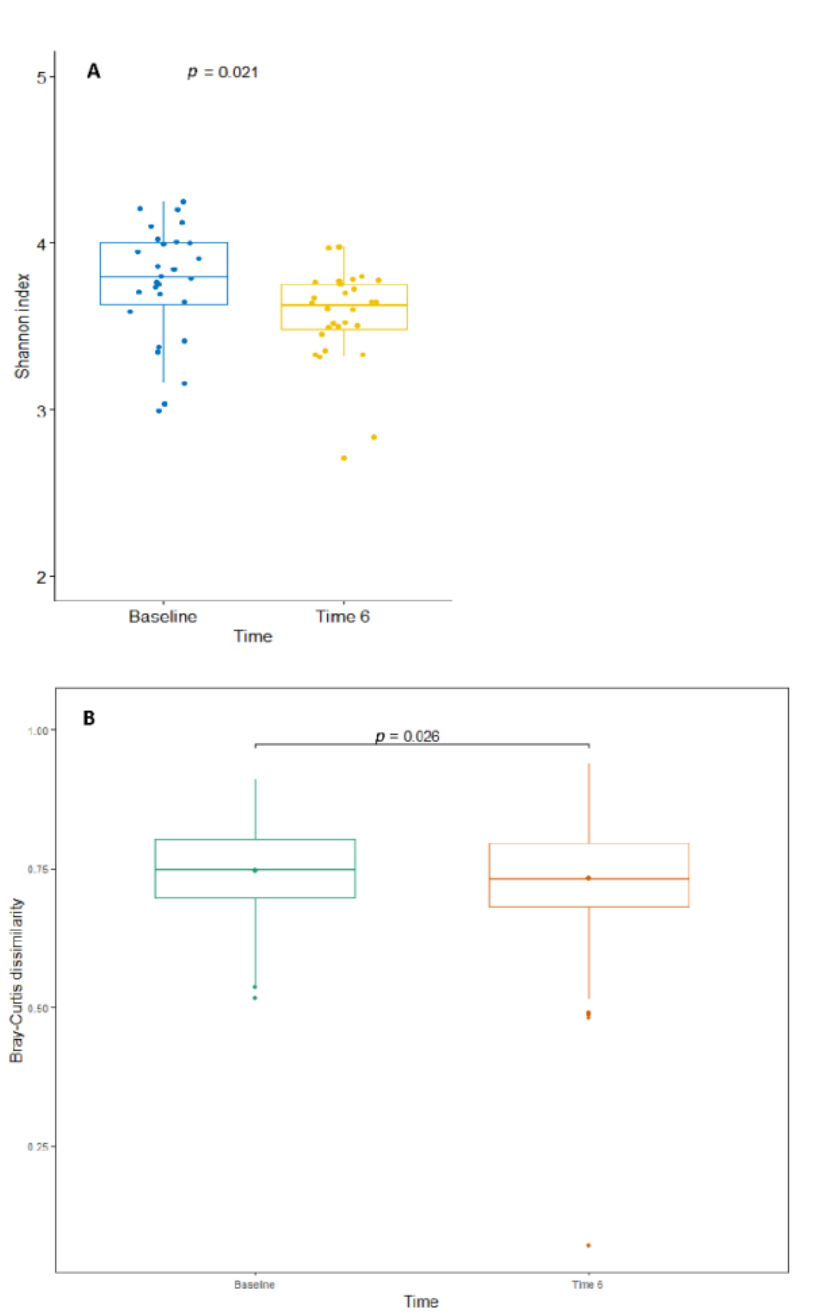
Figure 4. ( A ) Alpha diversity (using the Shannon index) and ( B ) beta diversity (using the Bray–Curtis dissimilarity metric) for all patients ( n = 28) from baseline (Time 0) to 6 months post-surgery (Time